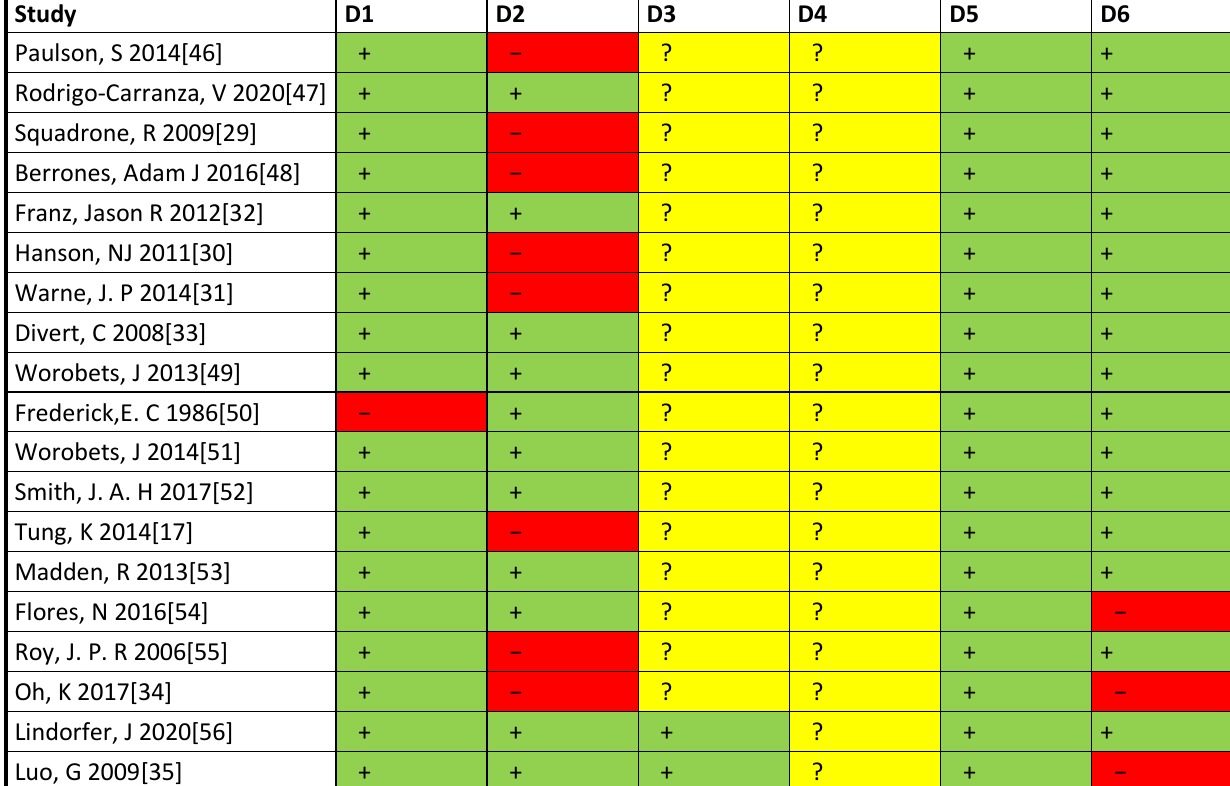
Figure 2. Risk of Bias of analyzed papers [17,29–35,46–56]. D1, Random sequence generation (selec- tion bias); D2, Allocation concealment (selection bias); D3, Blinding of participants and personnel (performance bias); D4, Blinding of outcome assessment (detection bias); D5, Incomplete outcome data (attrition bias); D6, Selective reporting (reporting bias). (−) high risk; (+) low risk; (?) unclear risk.